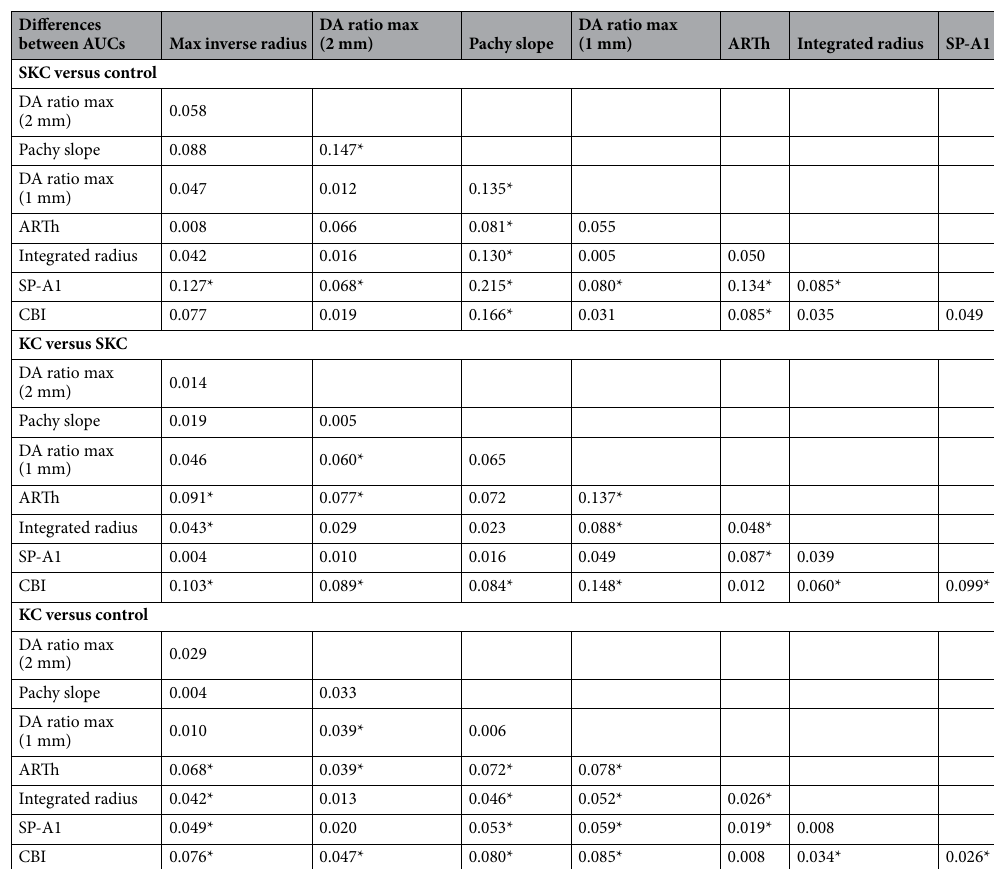
Table 4. Delong test results for pairwise comparison of the AUCs. SKC Subclinical keratoconus, KC Keratoconus, DA Deformation amplitude, ARTh Ambrósio’s relational thickness horizontal,